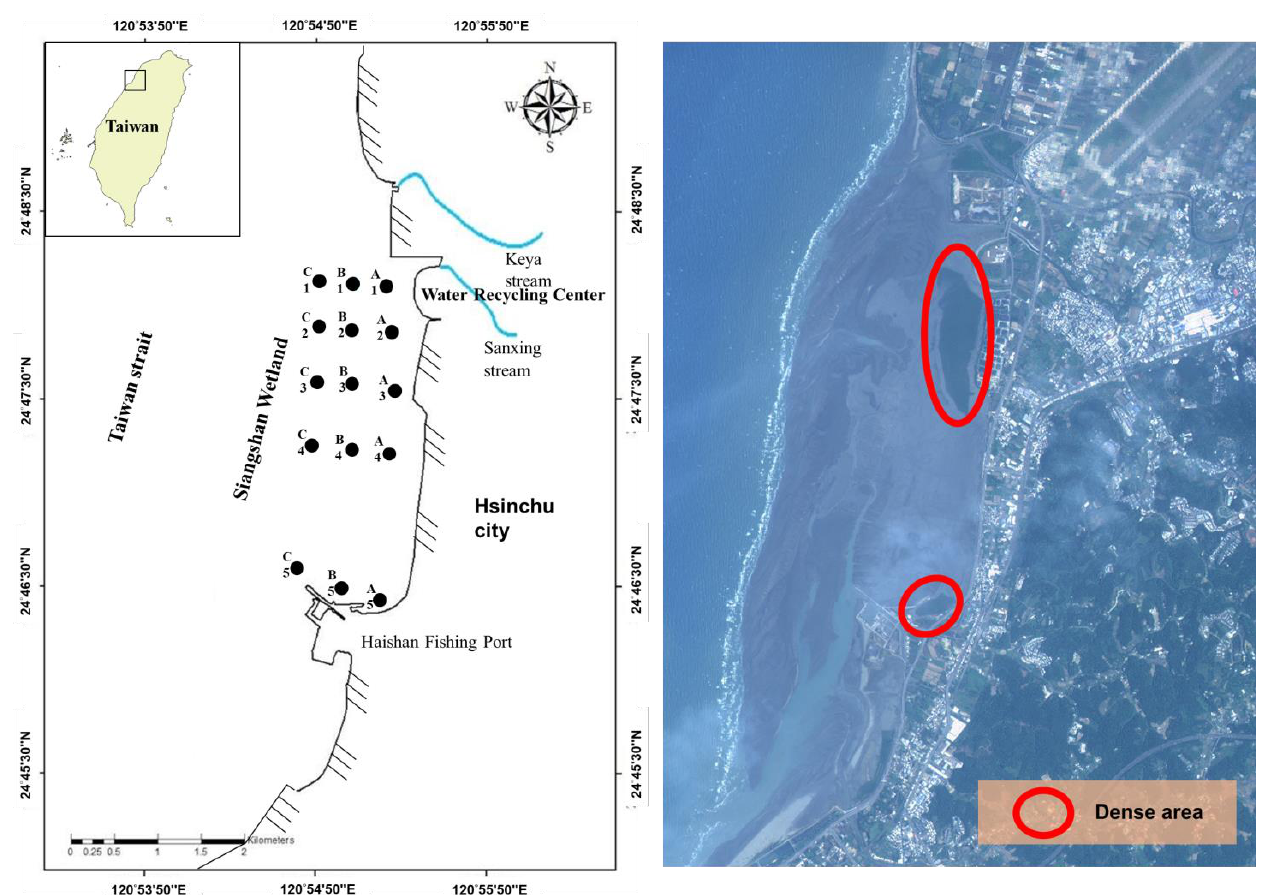
Figure 1. Sampling sites and satellite image of the Siangshan Wetland, Hsinchu, Taiwan.